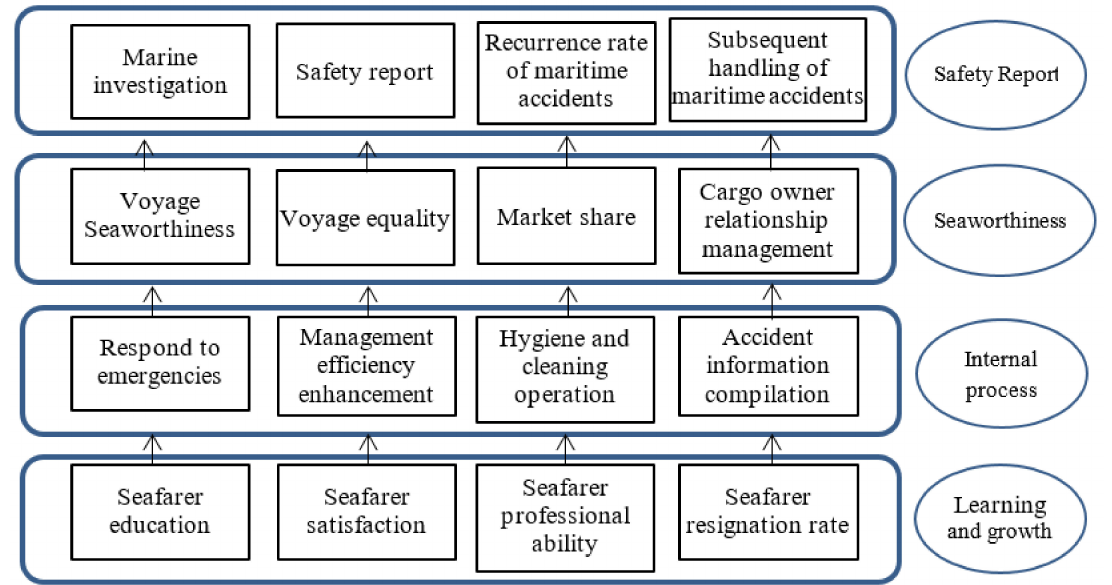
Figure 4. Risk accident assessment